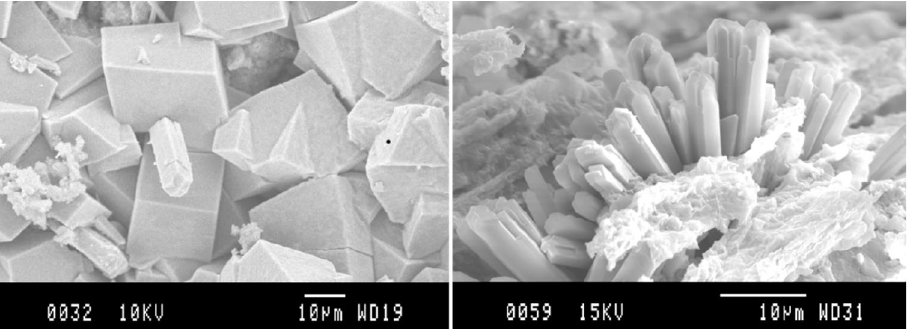
Figure 1. SEM images of the zeolitic phases present in the “Tufo Rosso a Scorie Nere”. Right: phillipsite crystals; Left: chabazite